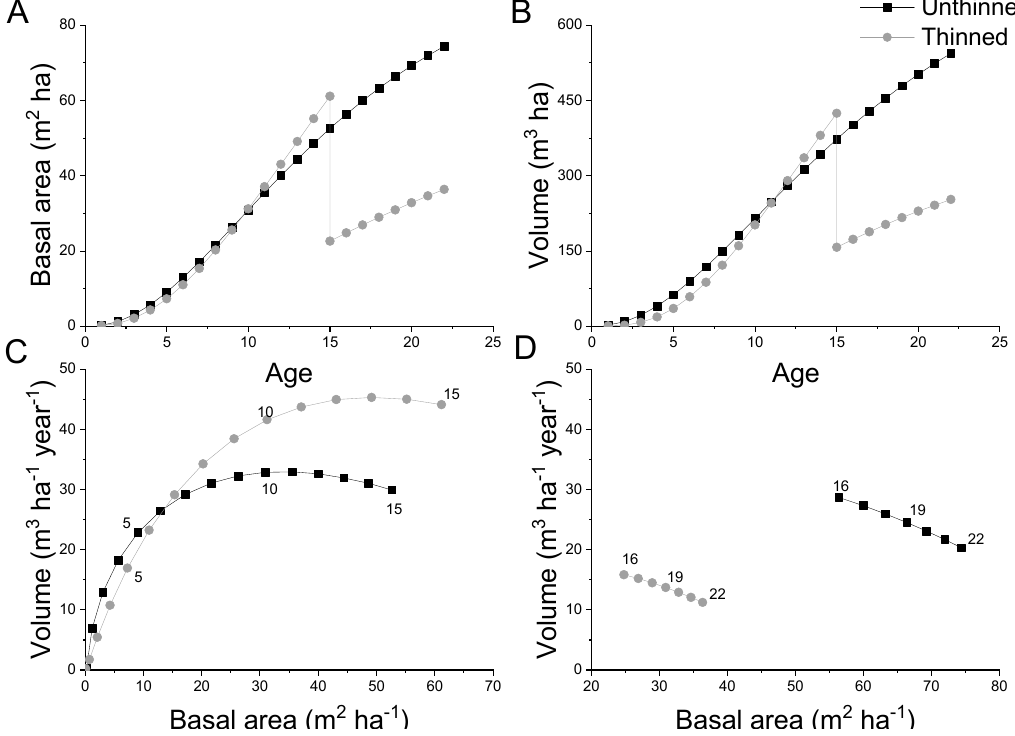
Figure 3. ( A ) Basal area and ( B ) wood volume per hectare in relation to tree age; the relationship of wood volume annual increment and basal area ( C ) before and ( D ) after thinning application in the 22nd year for P. patula trees. Symbols represent years for each stand.